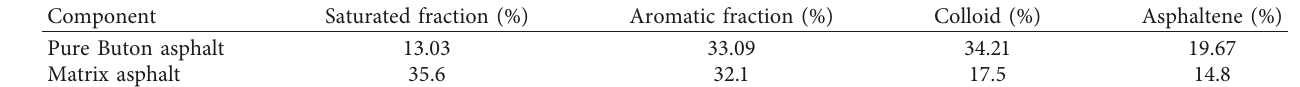
Table 4: Pure Buton gilsonite and SK90 # asphalt four components.